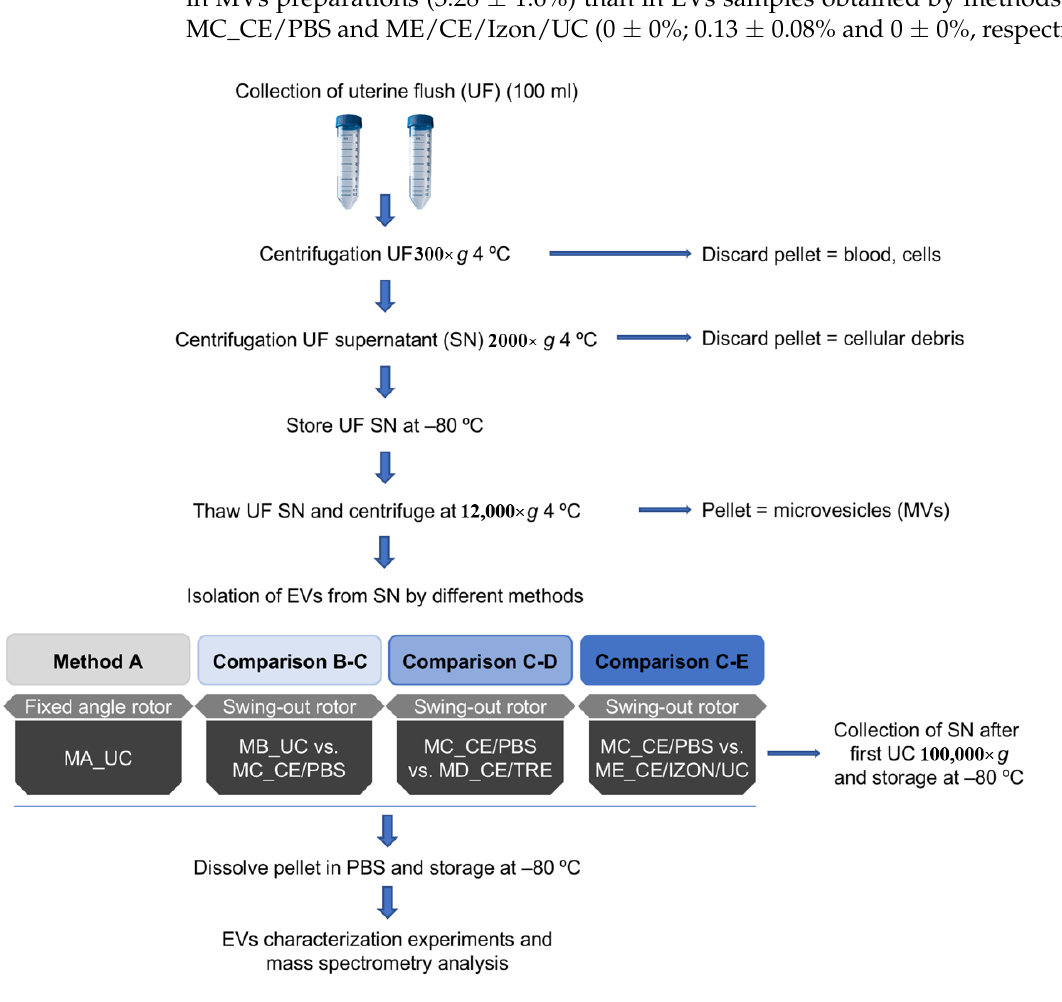
Figure 1. Schematic representation of the different protocols tested for extracellular vesicles (EVs) isolation from equine uterine fluid. Method A: By ultracentrifugation (UC) 100,000 × g (2 × ) 90 min using fixed angle Beckman rotor (MLA-55) and Beckman bottles (No. 355603) (MA_UC). Method B: UC with swing-out rotor MLS-50 (MB_UC). Method C: ultrafiltration by using Centricon filters (CE) followed by UC with swing-out rotor (MC_CE/PBS). Method D: ultrafiltration using CE with a washing step with PBS/25 mM trehalose (TRE) followed by UC (MD_CE/TRE). Method E: Combination of CE, followed by size exclusion chromatography (Izon qEV columns) and the collection of fractions enriched in EVs (7,8,9) and concentration of EVs by UC